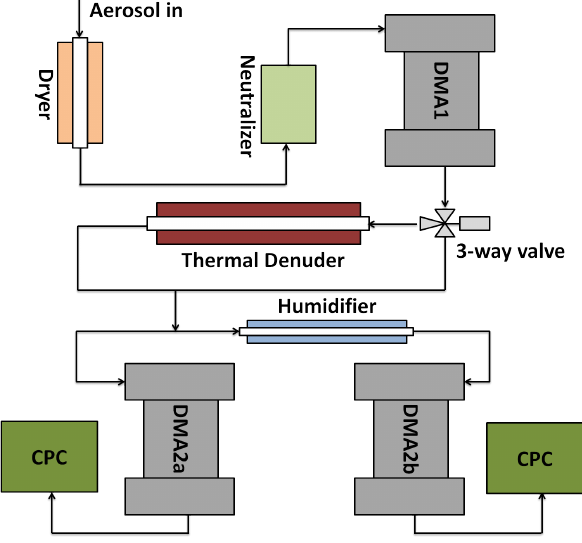
Fig. 1. A schematic of the VH-TDMA instrument